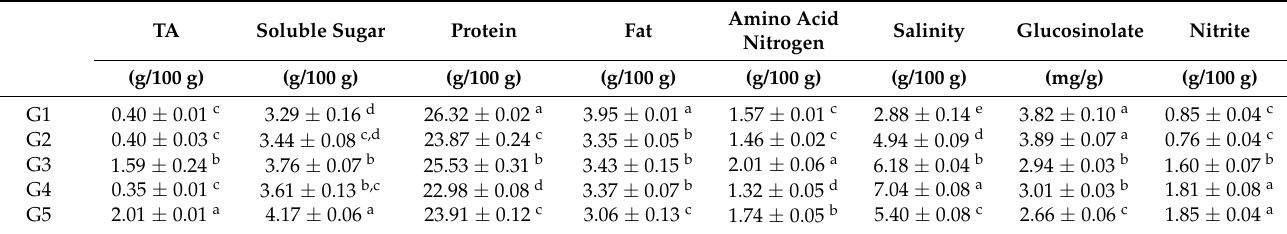
Table 1. Physical and chemical indexes of pickled BLS with different salt